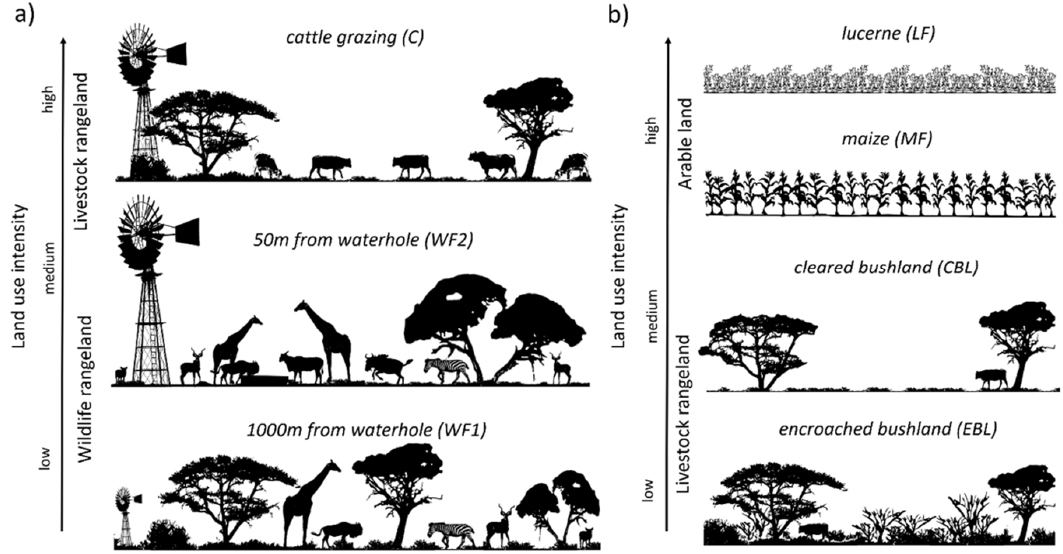
Figure 1. Study design: small mammal communities were investigated in three di ff erent habitat types (wildlife rangeland, livestock rangeland, arable land) with di ff erent land use intensities (‘low’, ‘medium’, ‘high’) on ( a ) private farmland south of ENP (low anthropogenic transformation) and ( b ) smallholder farmland in Tsumeb agricultural area (high anthropogenic